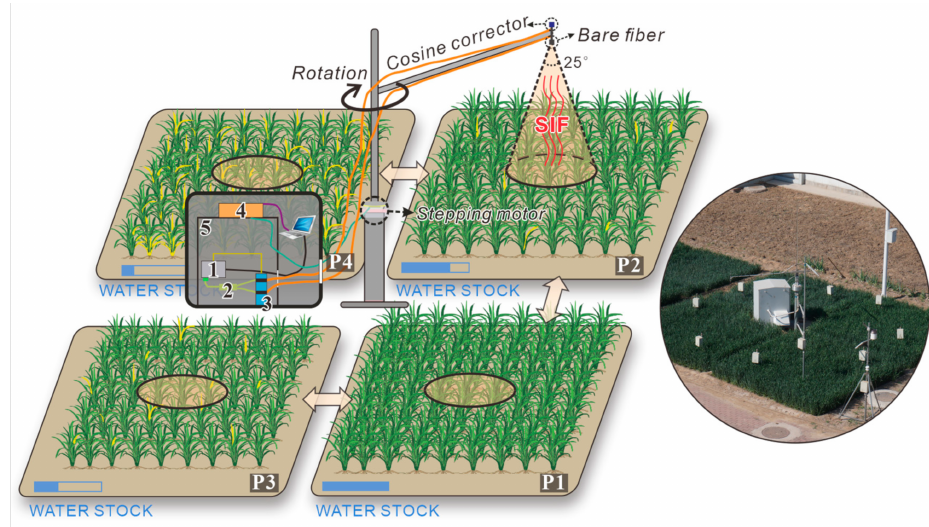
Figure 1. Experimental set-up (left) of solar-induced chlorophyll fluorescence measurements on four plots (P1~P4) with different irrigation treatments and a field photo (right). 1 = HR2000+ spectrometer; 2 = optic fiber; 3 = electronic switch; 4 = manipulator; 5 =